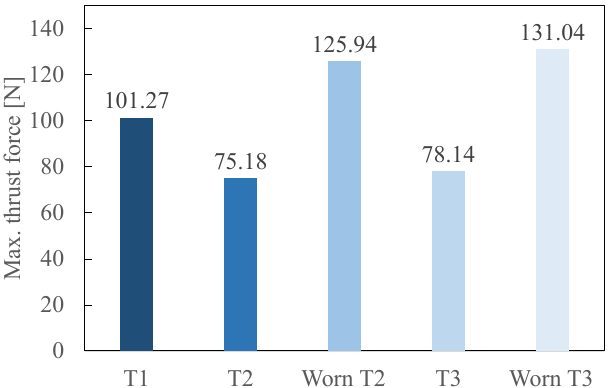
Figure 14. Maximal Thrust Force, F z,max , recorded when entering the GFRP plate (fresh and worn cutting tools).